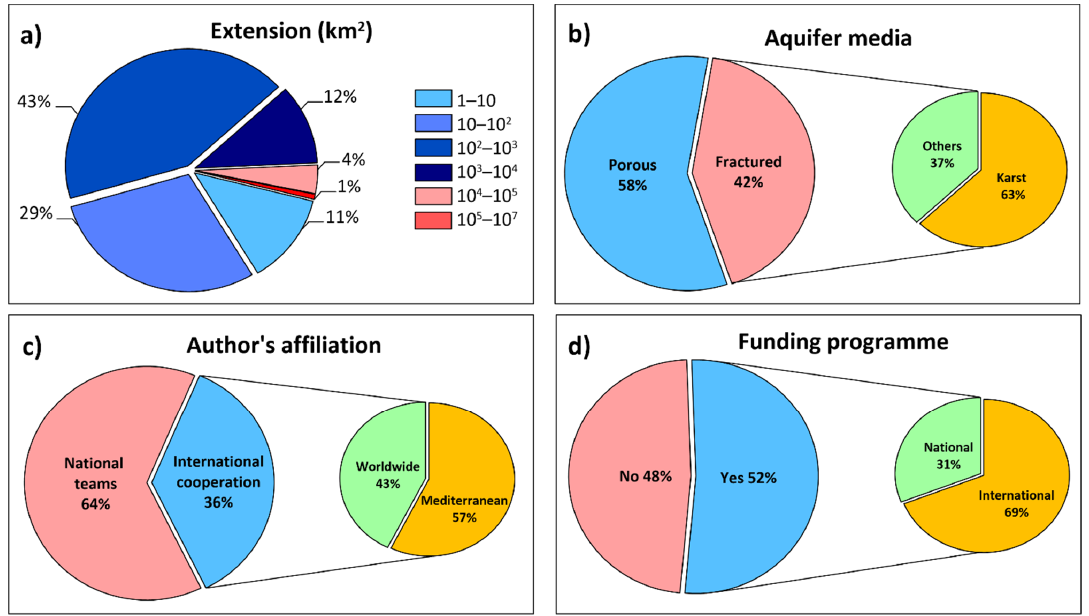
Figure 4. Geographical extension ( a ) and type of aquifer ( b ) of the studies focusing on GW salinization; relevance of international cooperation ( c ) and funding programmes ( d ) within the selected studies.